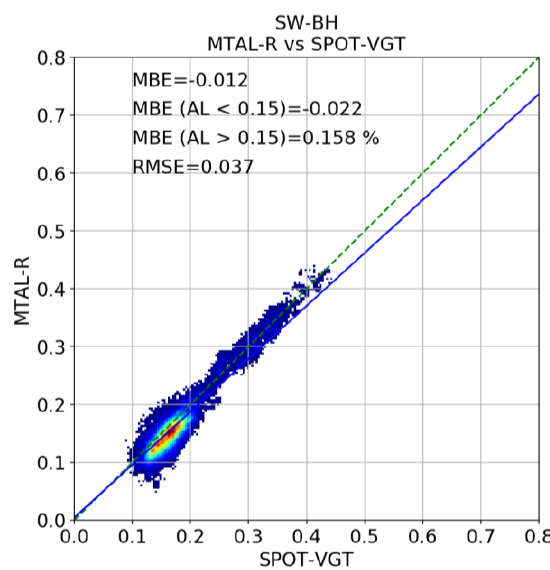
Figure 5. Remote Sens. 2018 , 10 , x FOR PEER REVIEW